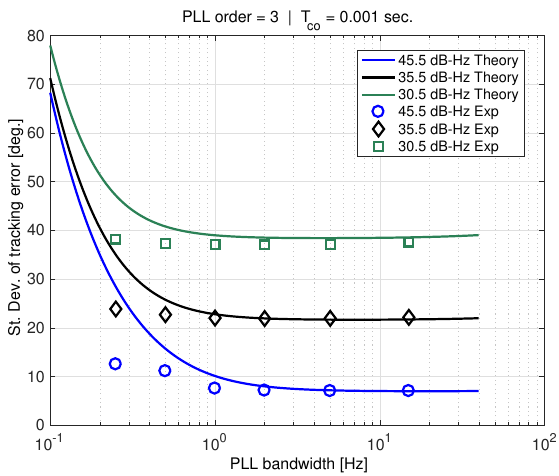
Figure 13. Experimental results with theory using Rb PSD model.